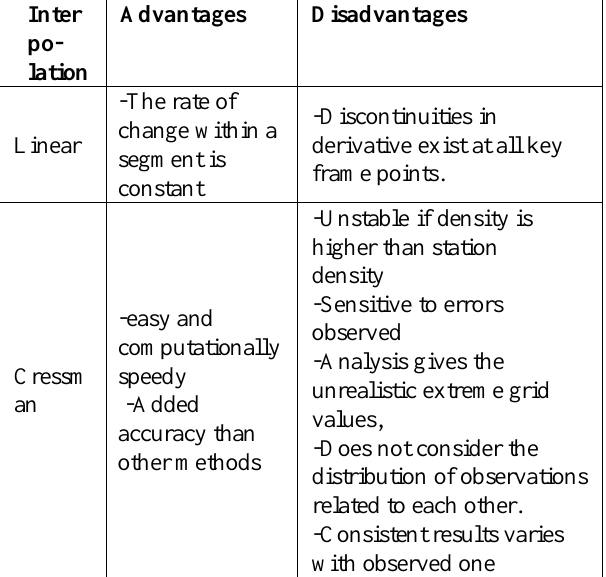
Table 1 : Pros and Cons of